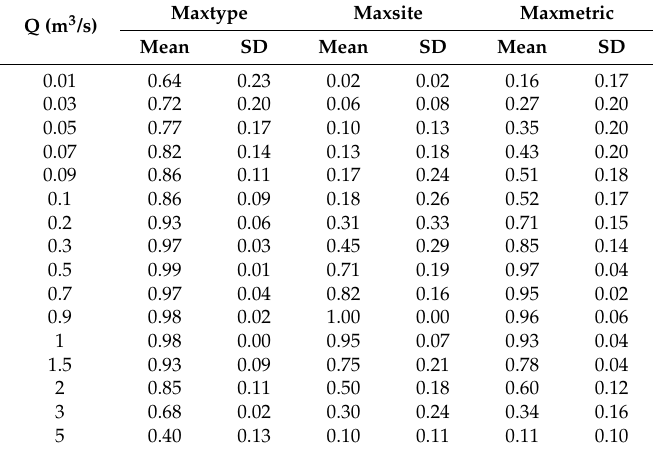
Table A5. Typological OFS means and standard deviations (SD) within the various κ -normalization alternatives for the Oinoi reach. The OFS values of RM1-2 and RM4 types for each discharge (Q) have been